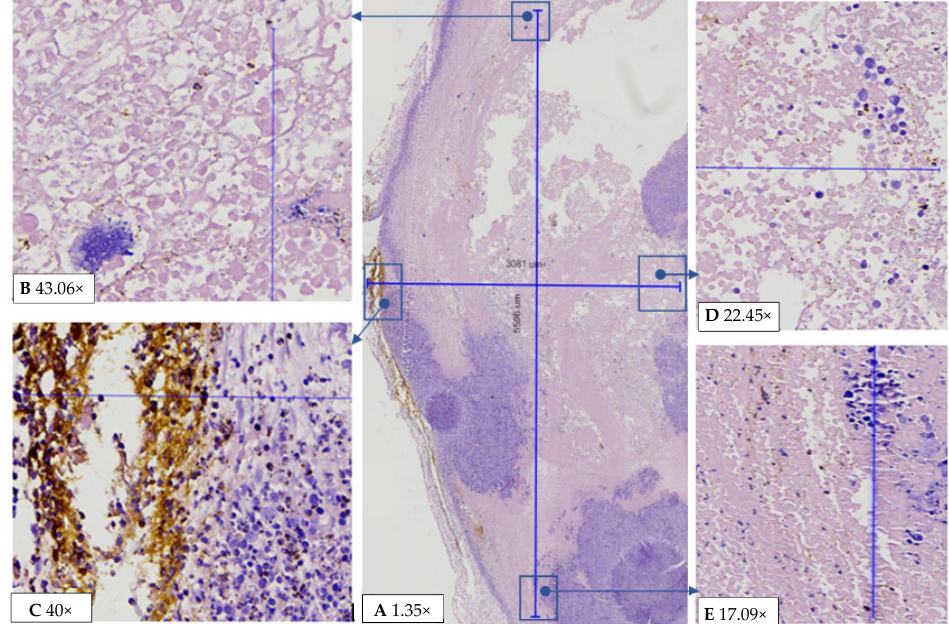
Figure 9. Significant tumor necrosis ( A – E ) and marked accumulation of mNPs and inflammatory cells at the tumor normal tissue interface. The tissue sample was acquired 6 h following intratumoral mNP delivery. Group IV mouse. H&E staining. ( A ) magnification: length, 5.596 µm; width, 3.081 µm.